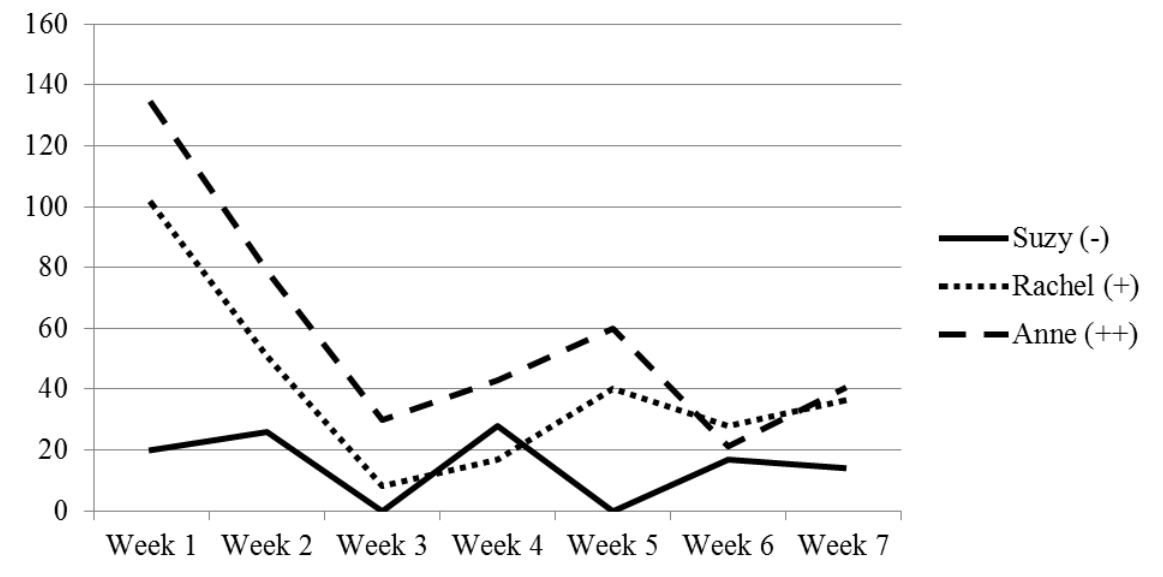
Figure 6. Number of Page Views Across Time During the First Seven Weeks of the Course. Note. (-) = failed the course, (+) = successfully completed with minimal page views, (++) = successfully completed with many page views.